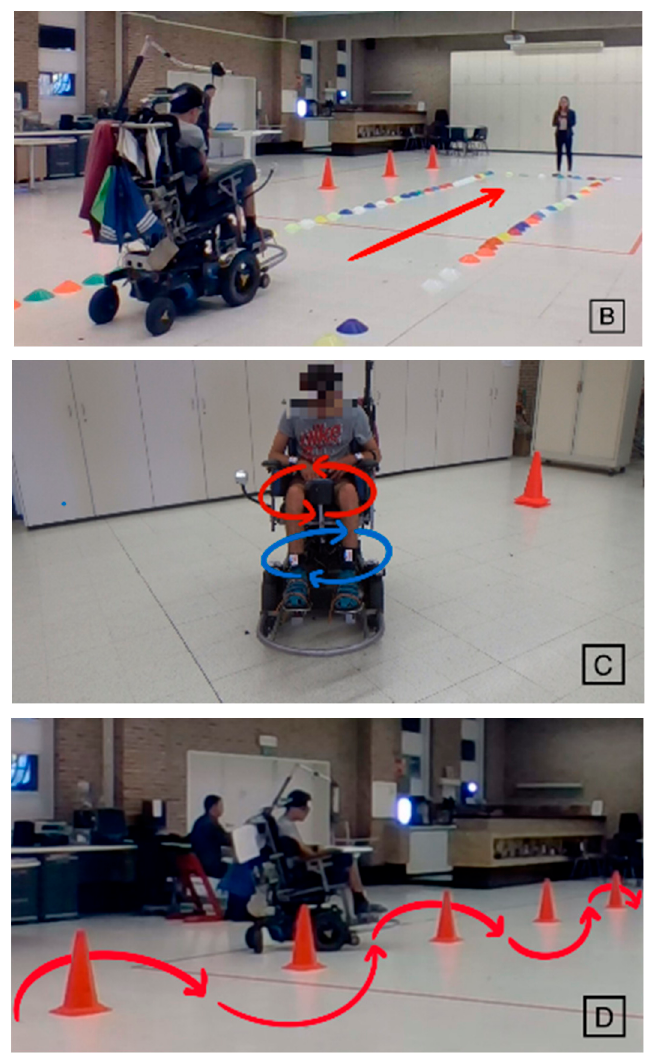
Figure 2. Data collection set–up with five standardized powered mobility tasks: ( A ) T1, Independent driving; ( B ) T2, driving through a created corridor; ( C ) T3, 360° turn to the left (red arrow); T4, 360° turn to the right (blue arrow); ( D ) T5, slalom.